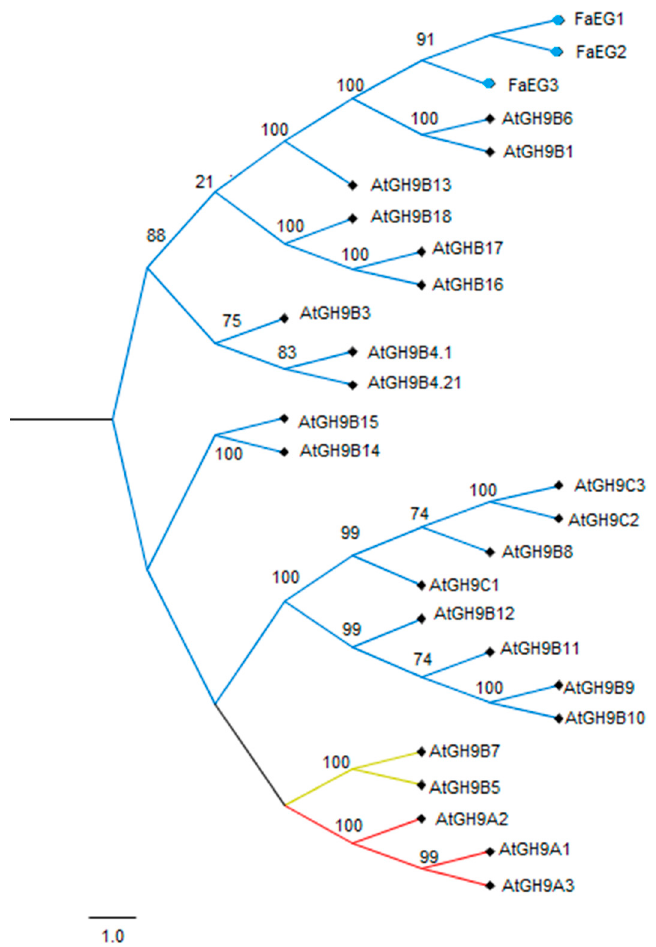
Figure 1. Phylogenic analysis of FaEG1 with different orthologs sequences from Arabidopsis thaliana and F. x ananassa . The phylogenetic tree was constructed using the neighbor-joining method (Jones–Taylor–Thornton substitution model) and bootstrap analysis of 5000 replicates.